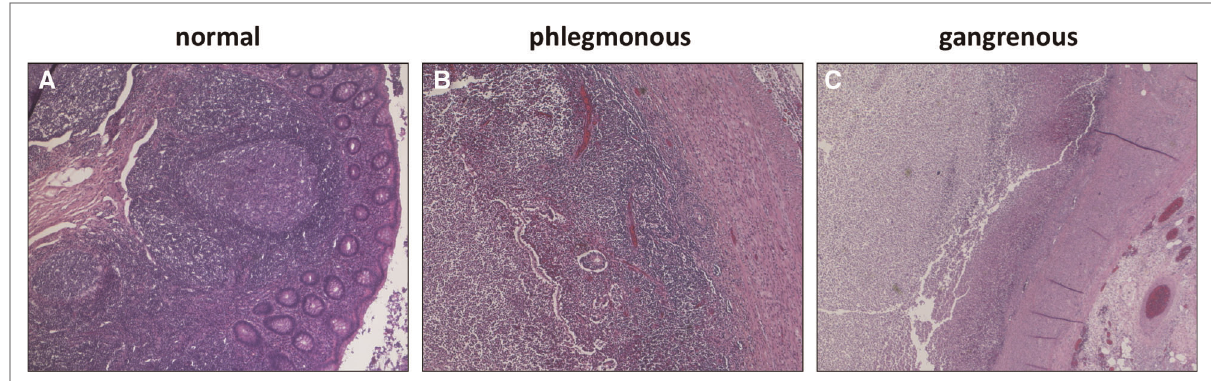
FIGURE 1 Histopathological features of the vermiform appendix (40): ( A ) Normal lymphofollicular structures of unin fl amed appendix. ( B ) transmural granulocyte in fi ltration and oedema in phlegmonous appendicitis. ( C ) transmural necrosis and fi brinous-purulent in fl ammation in gangrenous